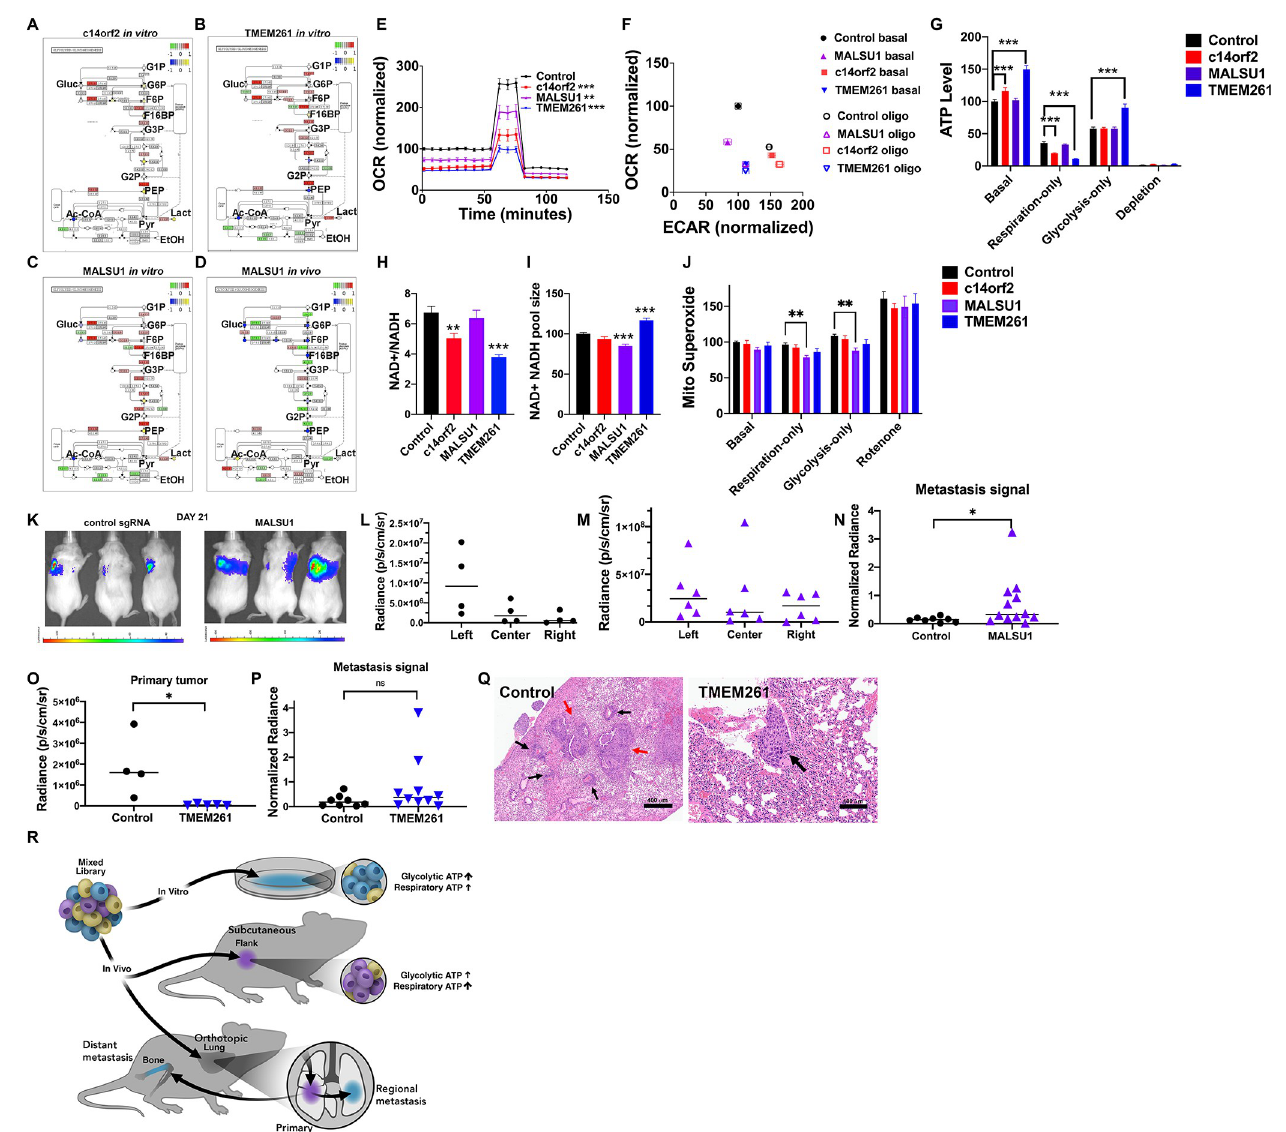
Fig 4. Mito-respiratory gene silencing alters metabolic network structures and in vivo tumor growth. (A-D ) Pathway analysis of HCC827 cells expressing individual CRISPRi sgRNA (control or mito-respiratory hits c14orf2 , MALSU1 , or TMEM261 ) grown in vitro ( A - C ) or HCC827 cells expressing an individual CRISPRi sgRNA against MALSU1 grown in vivo as flank tumor ( D ) was performed by integrating transcriptome and metabolomics data and plotted on a KEGG graph depicting pathway components for glycolysis/gluconeogenesis. ( E) H1975 cells transduced with either control sgRNA or individual sgRNAs against c14orf2 , MALSU1 , or TMEM261 were analyzed using Seahorse. OCR shown, compilation of 3 independent experiments, each analyzing n = 4 per cell line, normalized to cell numbers. Mean shown, 2-way ANOVA, �� p < 0.01, ��� p < 0.001. ( F) OCR and ECAR measurements for cells grown under basal or forced glycolysis (oligomycin). Compilation of 3 independent experiments, each analyzing n = 4 replicates per cell line and normalized to cell numbers. ( G ) ATP levels were measured in different substrate conditions (basal, respiratory (10 mM 2DG), glycolytic (5 μ M oligomycin) or depletion (no glucose or pyruvate)) mean and SEM shown, 2-way ANOVA, ��� p < 0.001). ( H, I) NAD+/NADH ratios and NAD+/NADH pool size. Shown are compilation of 2 independent experiments �� p < 0.01, ��� p < 0.001. ( J ) MitoSox assay measuring mitochondrial superoxide. Compilation of 3 independent experiments, each analyzing n = 4 replicates per cell line. Two-way ANOVA, �� p < 0.01. ( K ) Cells expressing either control sgRNA or MALSU1 sgRNA were injected orthotopically into the left lungs of mice, then mice were imaged using BLI 21 days postinjection. ( L) Day 21 radiance within the left 1/3, central 1/3, and right 1/3 chest regions in mice injected with control sgRNA tumor cells. N = 4 mice, mean shown. ( M ) Day 21 radiance within left 1/3, central 1/3, and right 1/3, chest regions in mice injected with MALSU1 sgRNA tumor cells. N = 6 mice, mean shown. ( N ) Central 1/3 and contralateral right 1/3 lung radiance each normalized to the matched left 1/3 radiance for control and MALSU1 mice, mean shown, t test � p < 0.05. ( O ) Day 21postinjection radiance within the left 1/3 chest in mice injected with either control or TMEM261 -silenced tumor cells ( n = 4 mice for control, n = 5 mice for TMEM261, mean shown Mann– Whitney test, � p < 0.05). ( P ) Day 28 postinjection central 1/3 and contralateral right 1/3 lung radiance, each reading normalized to the matched left 1/3 radiance for control and TMEM261 cells ( n = 4 mice and n = 5 mice, respectively) mean shown, Mann–Whitney test, ns. ( Q) HE-stained sections of right